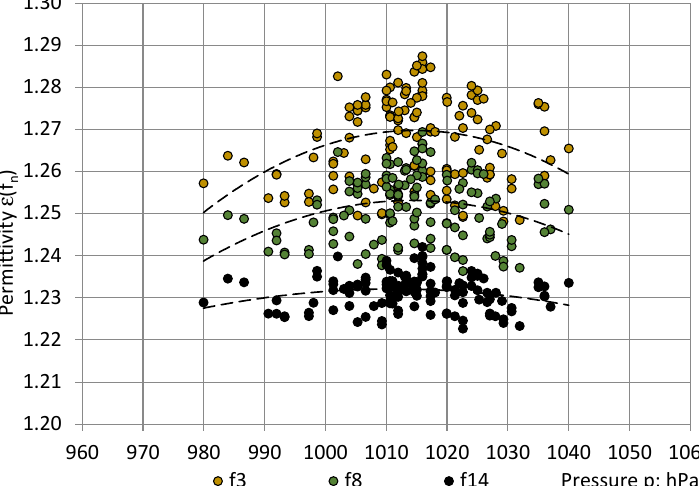
13 of 26 Figure 6. Correlation between the permittivity ε of PU SikaBlock ® -M150 foams (density of 144 kg/m 3 ) and the atmospheric temperature T in the test room at frequencies f 3 = 40 Hz (beige), f 8 =